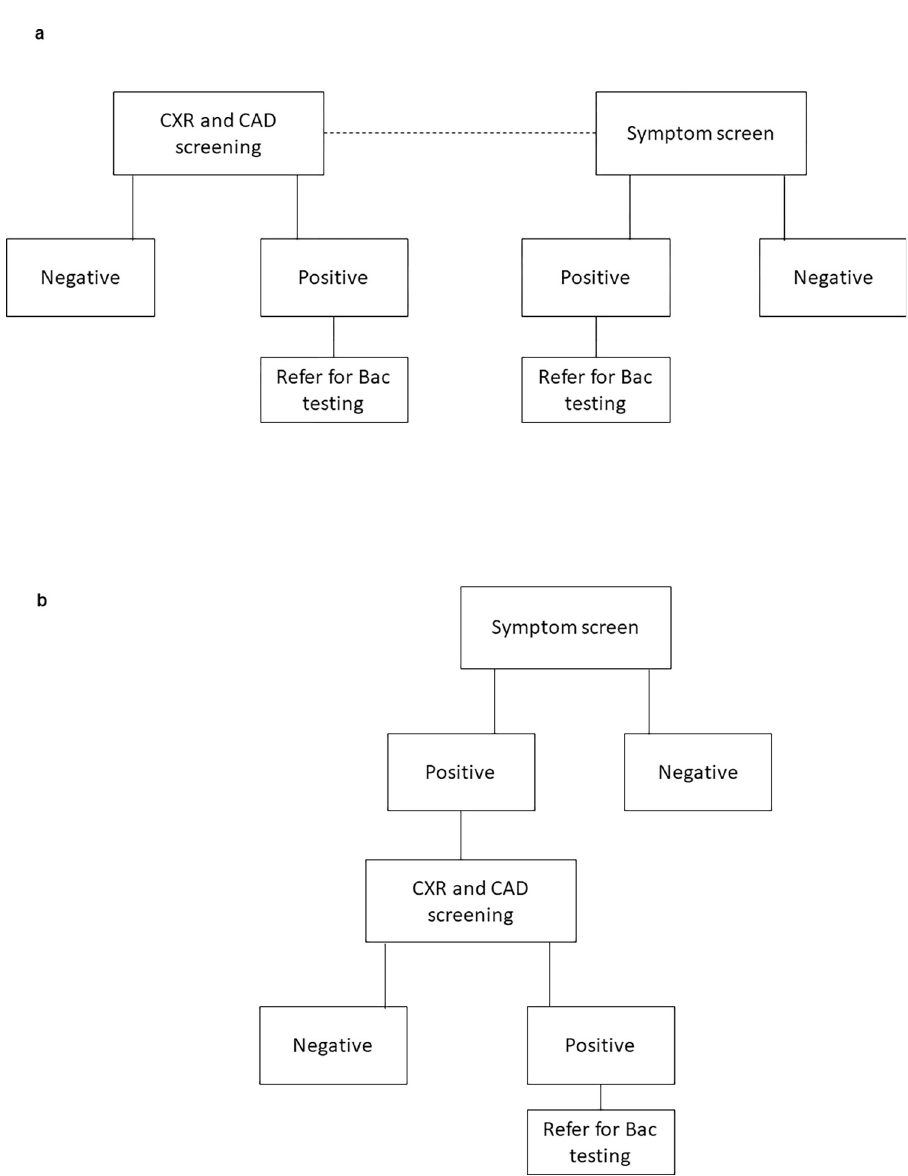
Fig 1. a: Parallel screening algorithm. b: Sequential screening